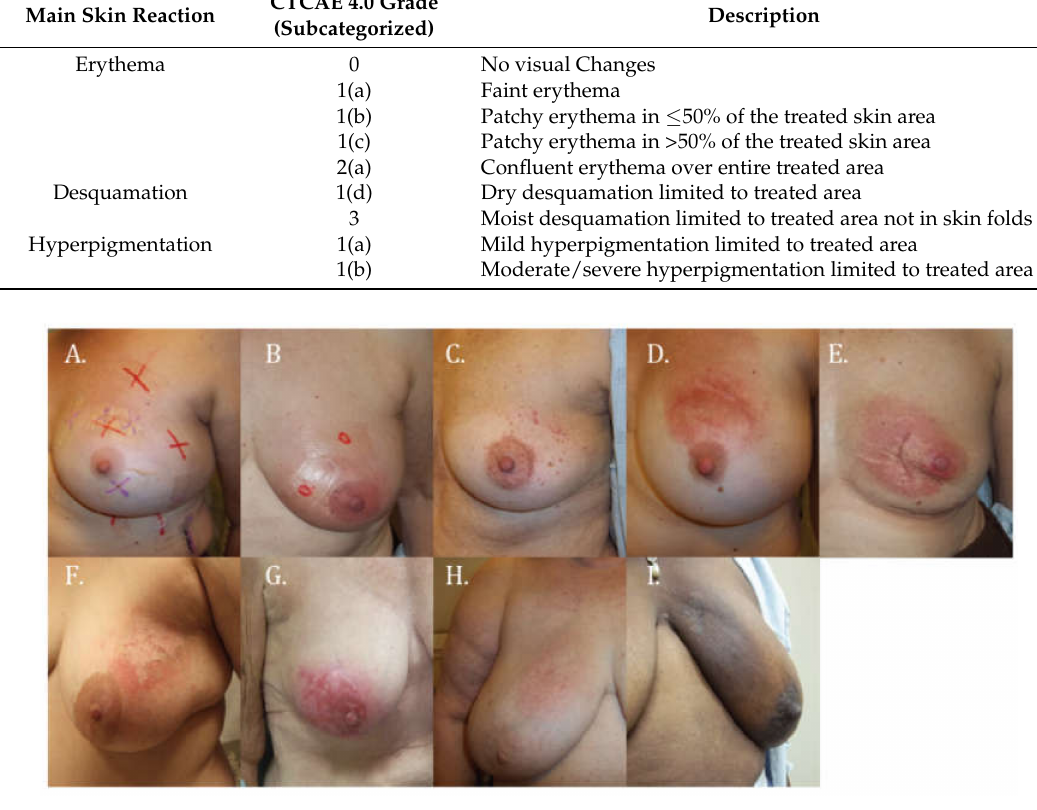
Figure 1. Medical photographs showing examples of different grades of erythema: ( A ) no